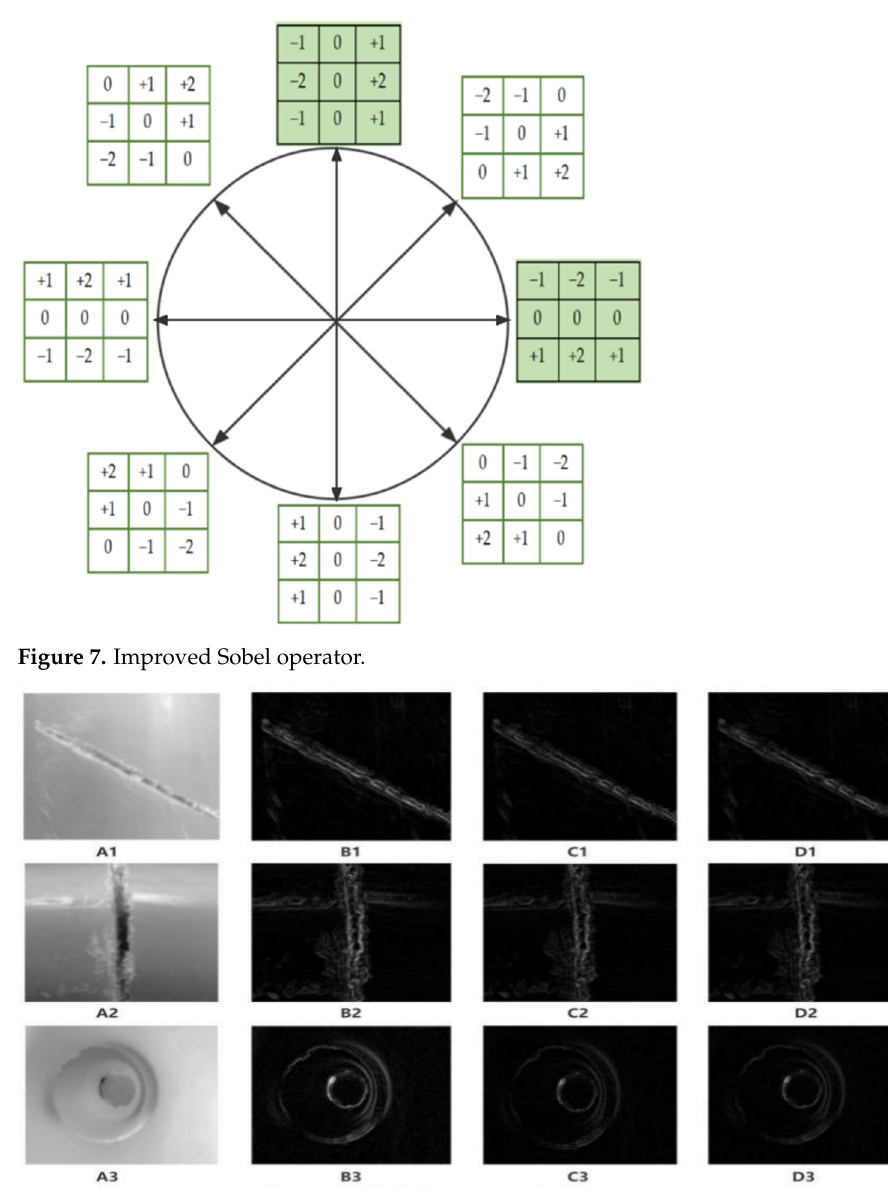
Figure 8. Comparison of pipeline defect image edge detection.